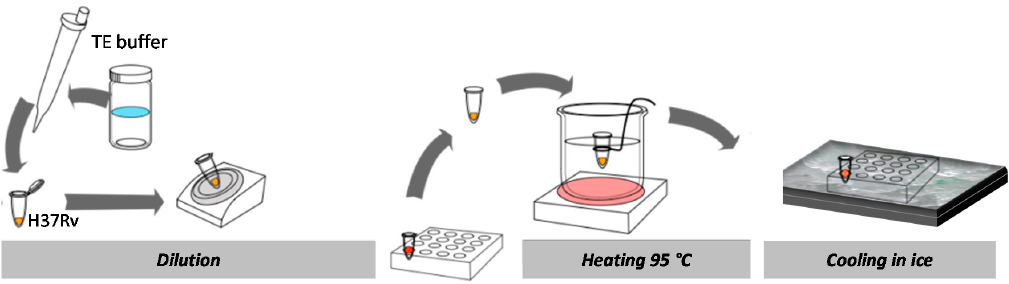
Figure 8. Genomic DNA extraction procedure from cultured cells.